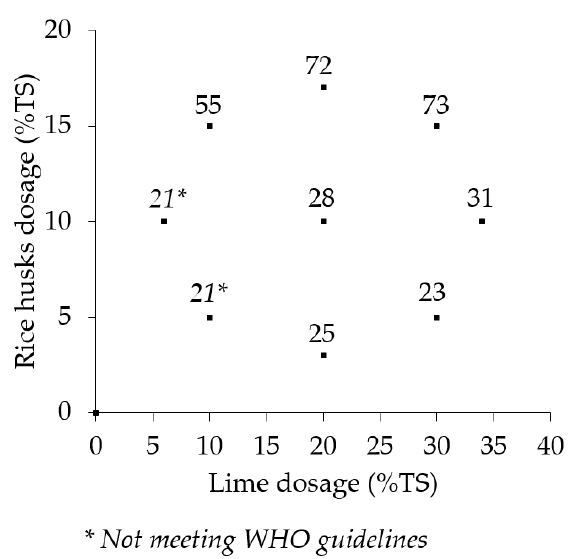
Figure 4. Percentage land area requirement reduction relative to the control.